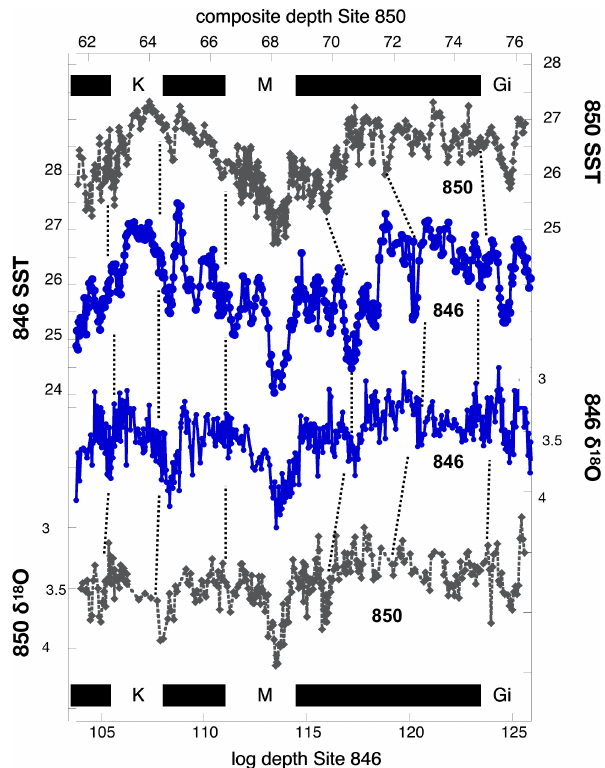
Figure 10. Comparison of the new alkenone-based SST and δ 18 O composites from Site 846 to composites from Site 850. The loca- tion of magnetic polarity reversals (reversed Kaena, Mammoth, and Gilbert polarity zones indicated by abbreviations) at Site 850 can be mapped to Site 846 with high confidence by the close corre- spondence of SST patterns (note: polarity determinations are only available at Site